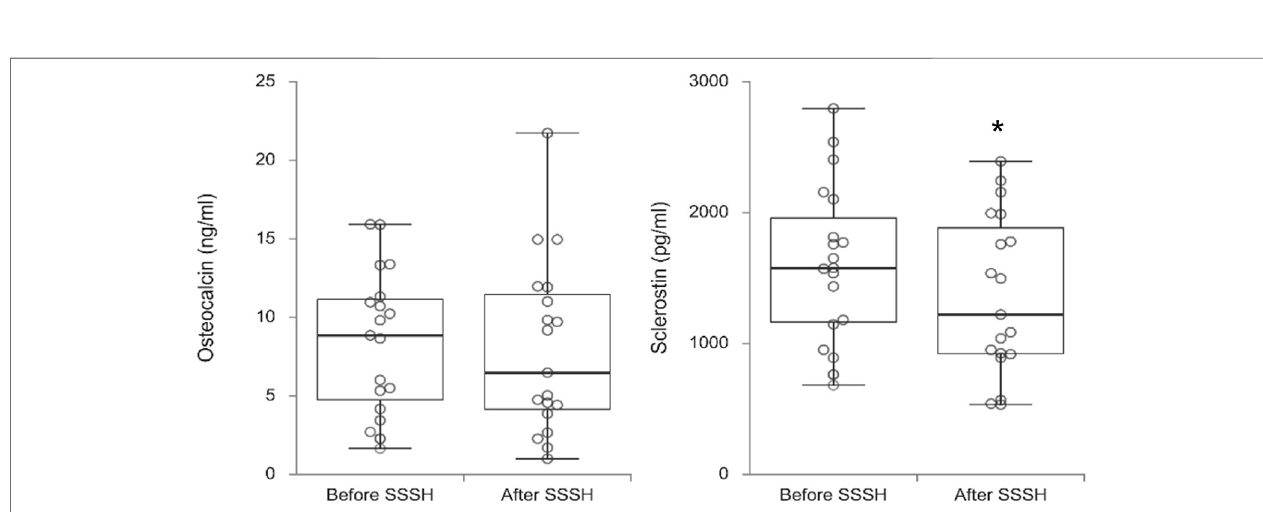
FIGURE 3 | Box plots of bone-related biomarkers osteocalcin and sclerostin before and after the exercise program SSSH. Signi fi cance indicated by * ( p = 0.003)